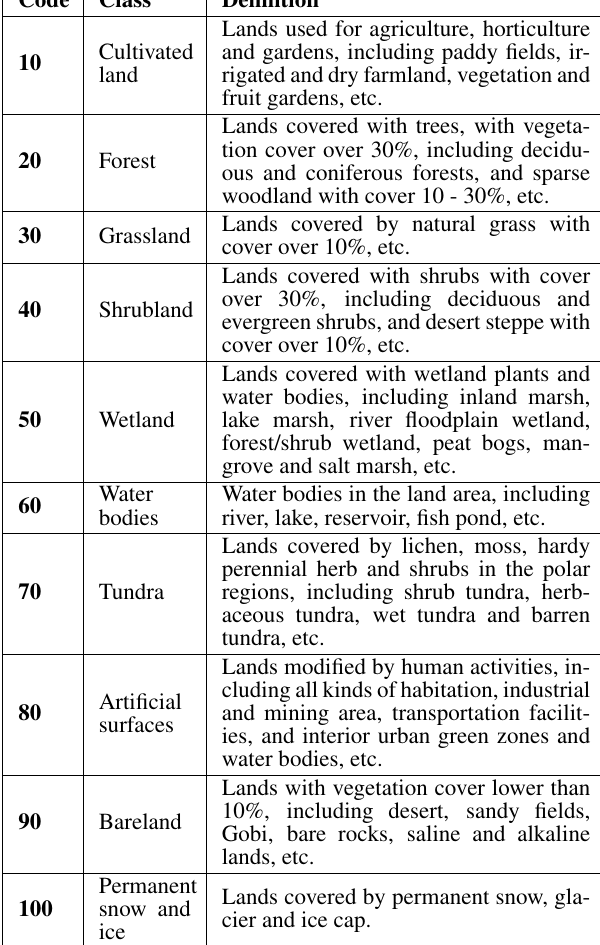
Table 1. Description of the GL30